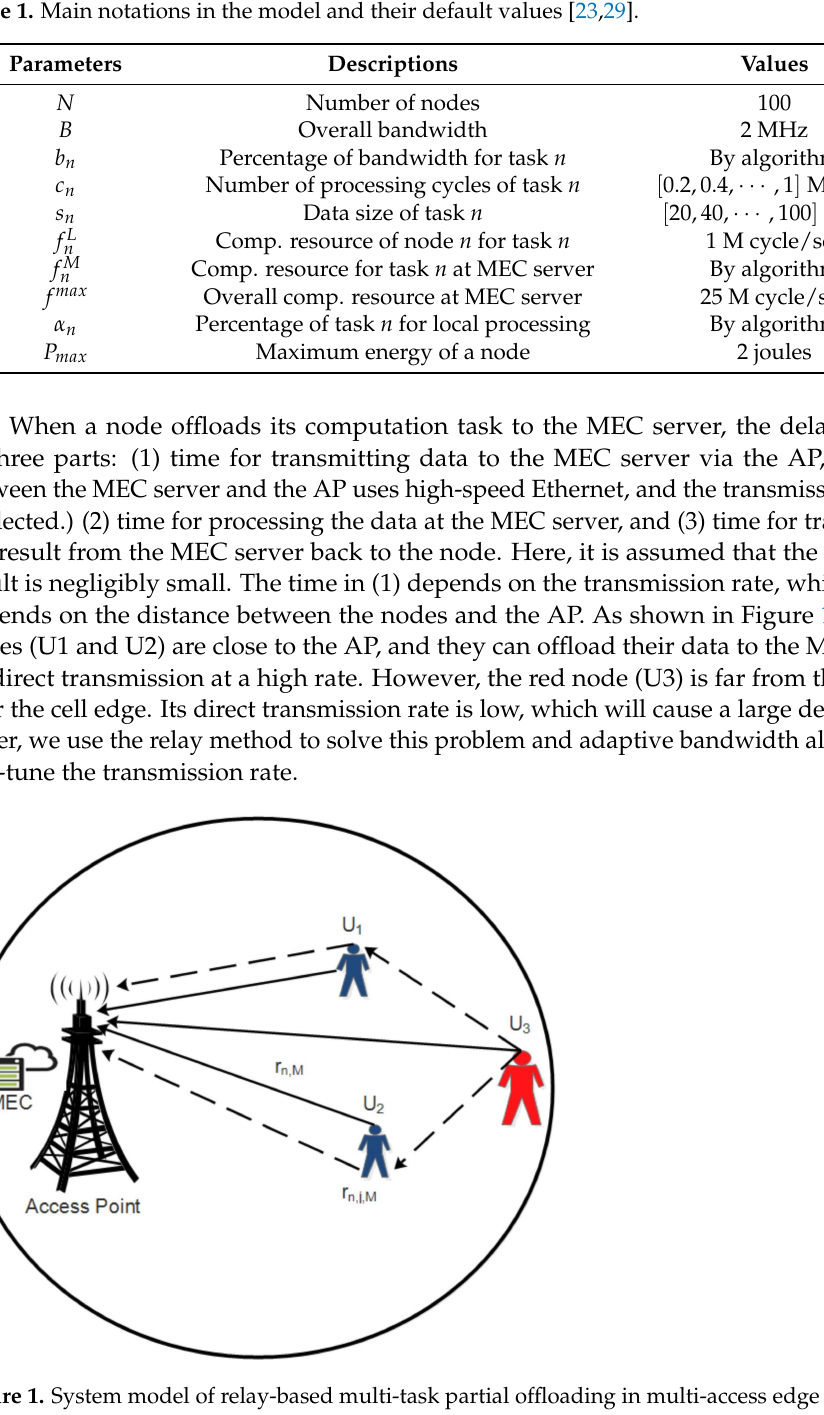
Figure 1. System model of relay-based multi-task partial offloading in multi-access edge